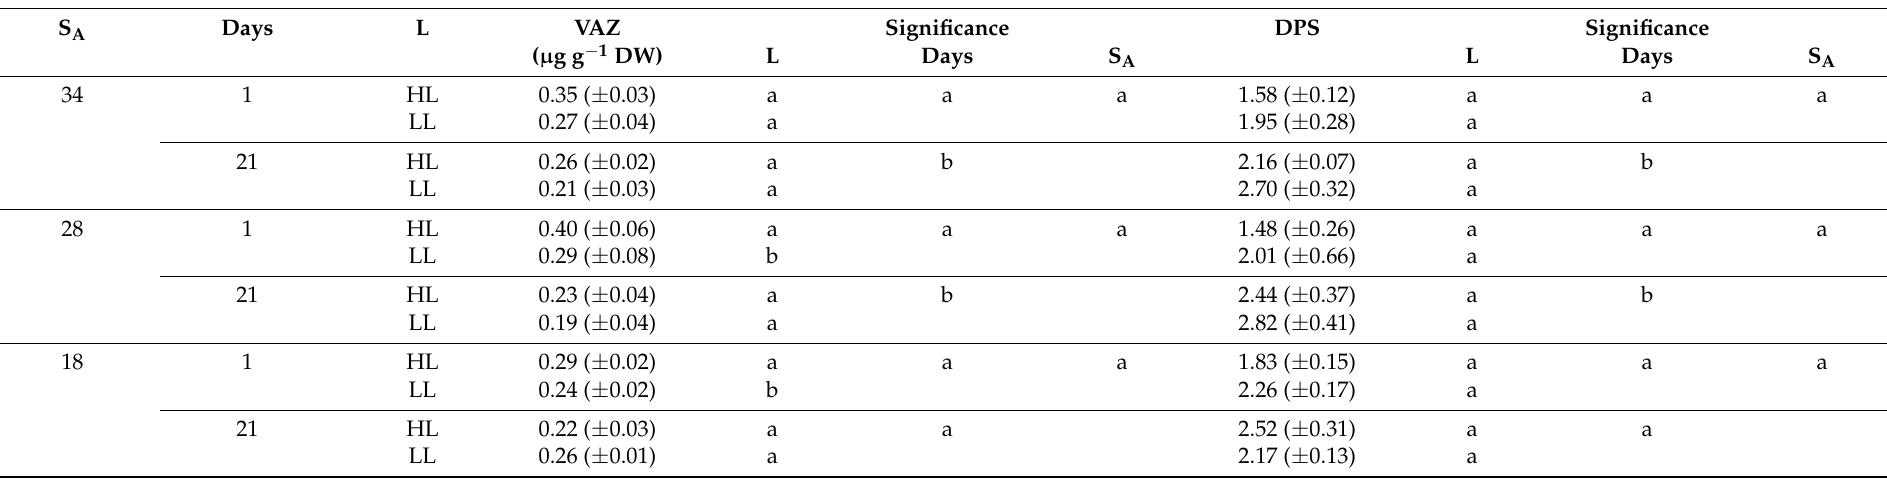
Table 3. The pool of the xanthophyll cycle—VAZ ( µ g g − 1 dry weight (DW)) and de-epoxidation state (DPS). Experimental set–up: salinity (S A )–Light (L) (High Light (HL)–Low Light (LL)) treatments of Desmarestia aculeata . Values are means ± SD (n = 3). For each parameter (L, Days, S A ), statistically significant differences are marked by different lowercase letters. For all the data, three-way ANOVA with post-hoc Tukey’s test was performed ( p <